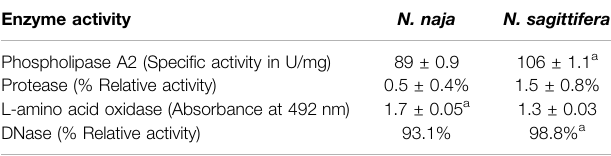
TABLE 2 | Biochemical activities of N. naja and N. sagittifera venoms. Enzyme